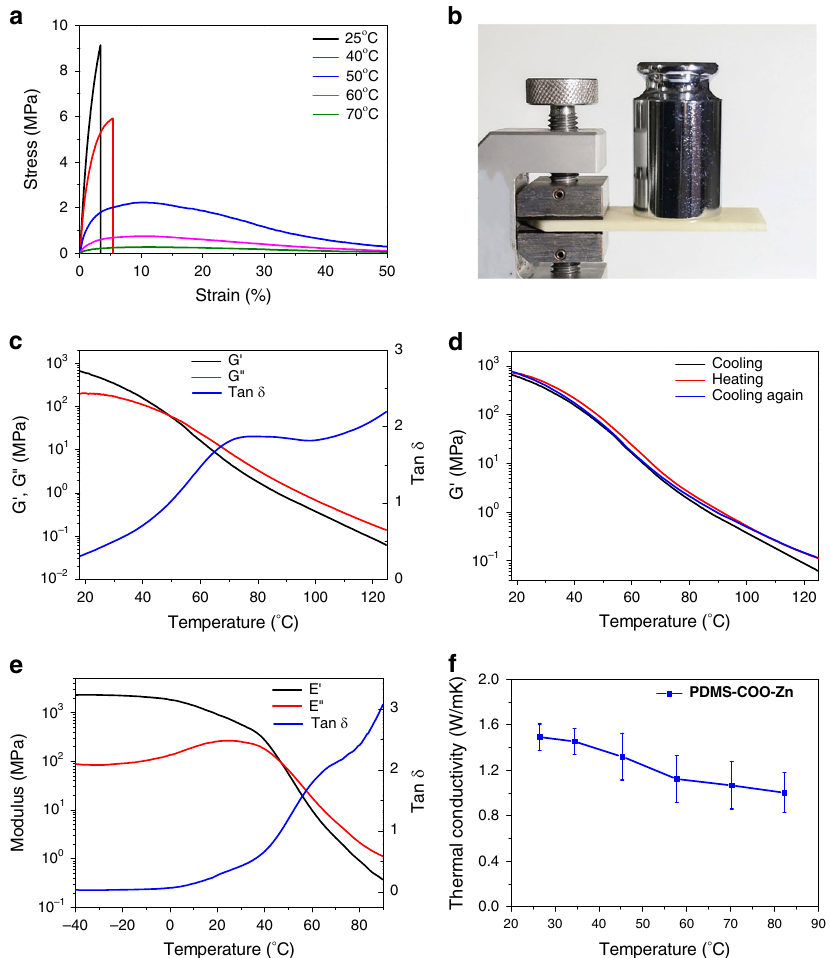
Fig. 2 Mechanical and thermal properties of PDMS-COO-Zn polymer. a Three-point fl exural stress-strain curves of PDMS-COO-Zn under various temperature. b The weight-bearing test of PDMS-COO-Zn polymer. c Temperature dependent rheology measurements of PDMS-COO-Zn polymer. d Cyclic temperature-sweep rheology measurements of PDMS-COO-Zn polymer (with the temperature changing rate of 2 °C min -1 ). e Temperature- sweep dynamic mechanical analysis result of PDMS-COO-Zn polymer. f Thermal conductive properties of PDMS-COO-Zn polymer. Error bars are the s.d. from triplicate